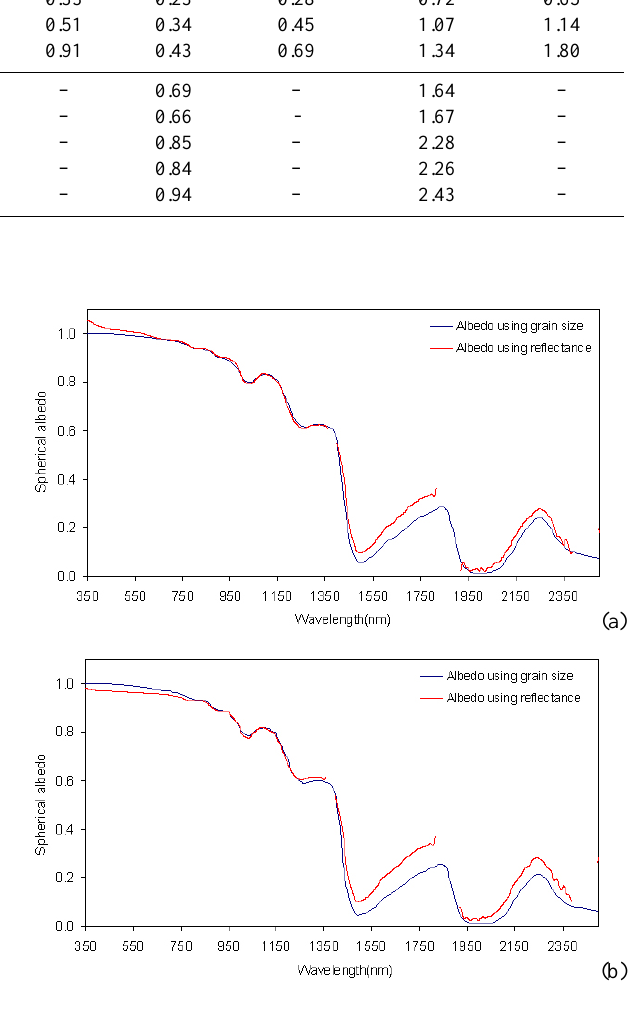
Fig. 12. The comparison between spherical albedo simulated us- ing grain size (using two channel model) and simulated from the reflectance measurements for snow Type-I (a) 09:30 and (b) 10:20 local